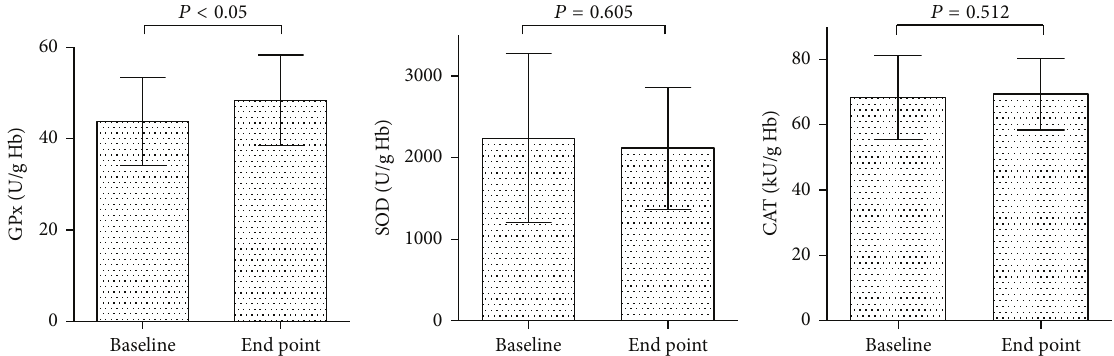
Figure 1: Activities of antioxidant enzymes at the baseline and end point of the study. Data are presented as mean ± SD. GPx = glutathione peroxidase; SOD = superoxide dismutase; CAT =